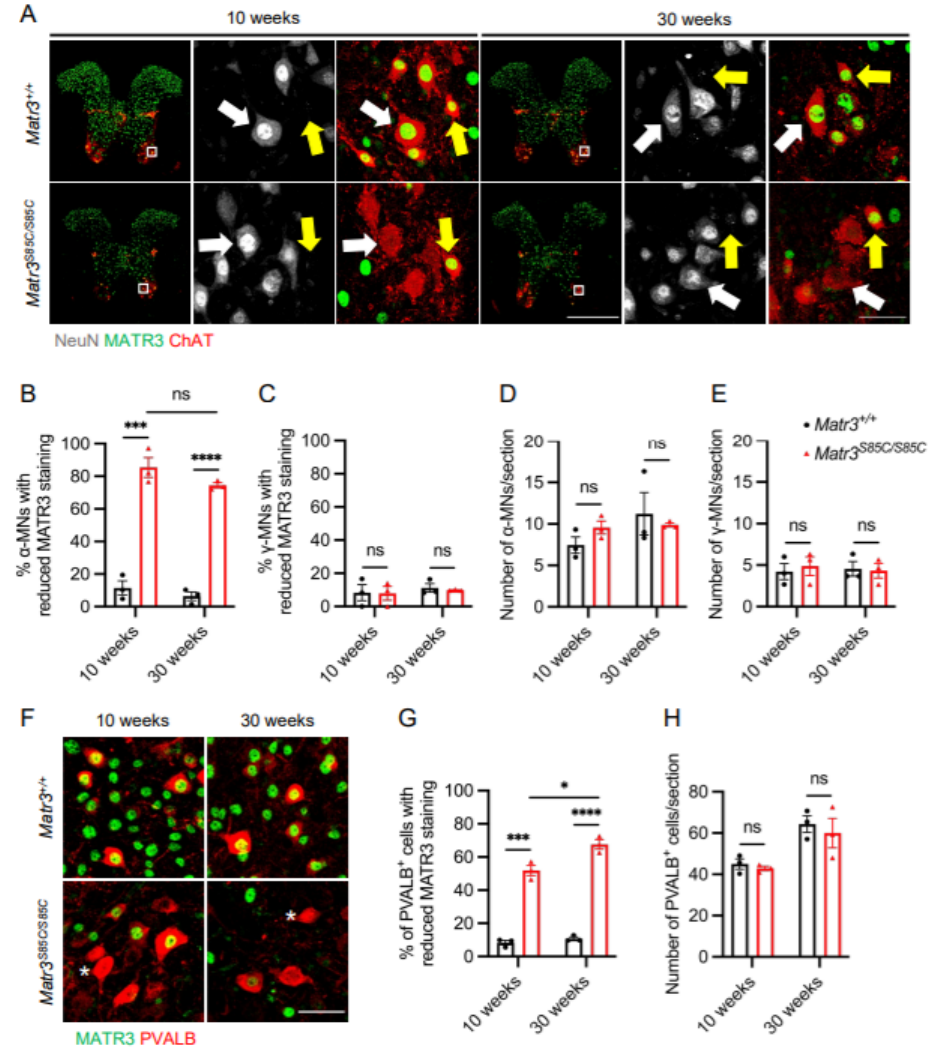
Figure 2. MATR3 loss in α -motor neurons and interneurons in the thoracic spinal cord of Matr3 S85C/S85C mice. ( A ) Representative images of 10 and 30 weeks thoracic spinal cord staining for α -motor neurons (ChAT + , NeuN + , denoted by white arrows) and γ -motor neurons (Chat + , NeuN − , denoted by yellow arrows). Scale bar for the spinal cord image denotes 500 µ m and the zoomed-in image denotes 50 µ m. Quantification of the percentage of motor neurons with reduced MATR3 staining in ( B ) α -motor neurons (10 weeks: n = 3 Matr3 +/+ , 3 Matr3 S85C/S85C ; 30 weeks: n = 3 Matr3 +/+ , 3 Matr3 S85C/S85C ) and ( C ) γ -motor neurons (10 weeks: n = 3 Matr3 +/+ , 3 Matr3 S85C/S85C ; 30 weeks: n = 3 Matr3 +/+ , 3 Matr3 S85C/S85C ). Quantification of the number of ( D ) α -motor neurons (10 weeks: n = 3 Matr3 +/+ , 3 Matr3 S85C/S85C ; 30 weeks: n = 3 Matr3 +/+ , 3 Matr3 S85C/S85C ) and ( E ) γ -motor neurons (10 weeks: n = 3 Matr3 +/+ , 3 Matr3 S85C/S85C ; 30 weeks: n = 3 Matr3 +/+ , 3 Matr3 S85C/S85C ). ( F ) Representative images of 10 and 30 weeks PVALB + interneurons in the thoracic spinal cord. Interneurons with reduced MATR3 staining are denoted by a white asterisk. Scale bar denotes 50 µm. ( G ) Quantification of the percentage of PVALB + interneurons with reduced MATR3 staining (10 weeks: n = 3 Matr3 +/+ , 3 Matr3 S85C/S85C ; 30 weeks: n = 3 Matr3 +/+ , 3 Matr3 S85C/S85C ). ( H ) Quantification of the number of PVALB + interneurons (10 weeks: n = 3 Matr3 +/+ , 3 Matr3 S85C/S85C ; 30 weeks: n = 3 Matr3 +/+ , 3 Matr3 S85C/S85C ). Bar graph heights depict mean ± SEM, with each datapoint representing an animal. * p < 0.05, *** p < 0.001, **** p < 0.0001, ns = not significant.